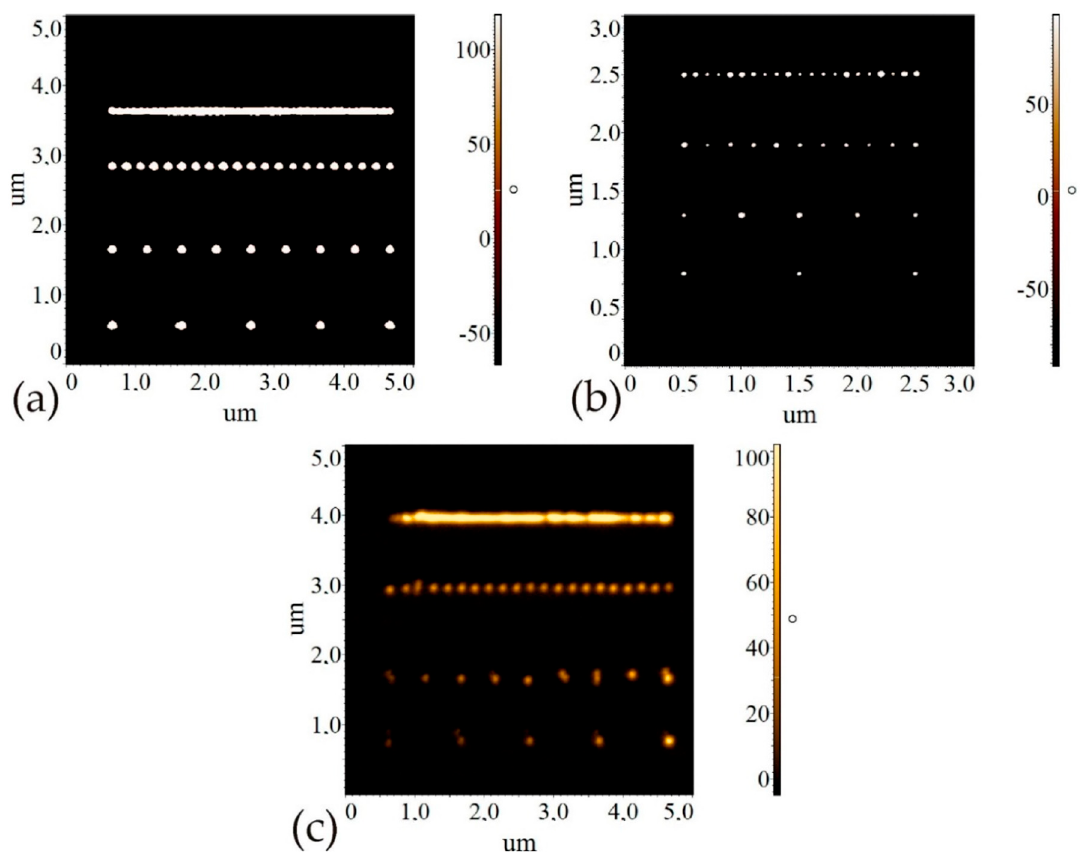
ff erent conditions of AFM-tip